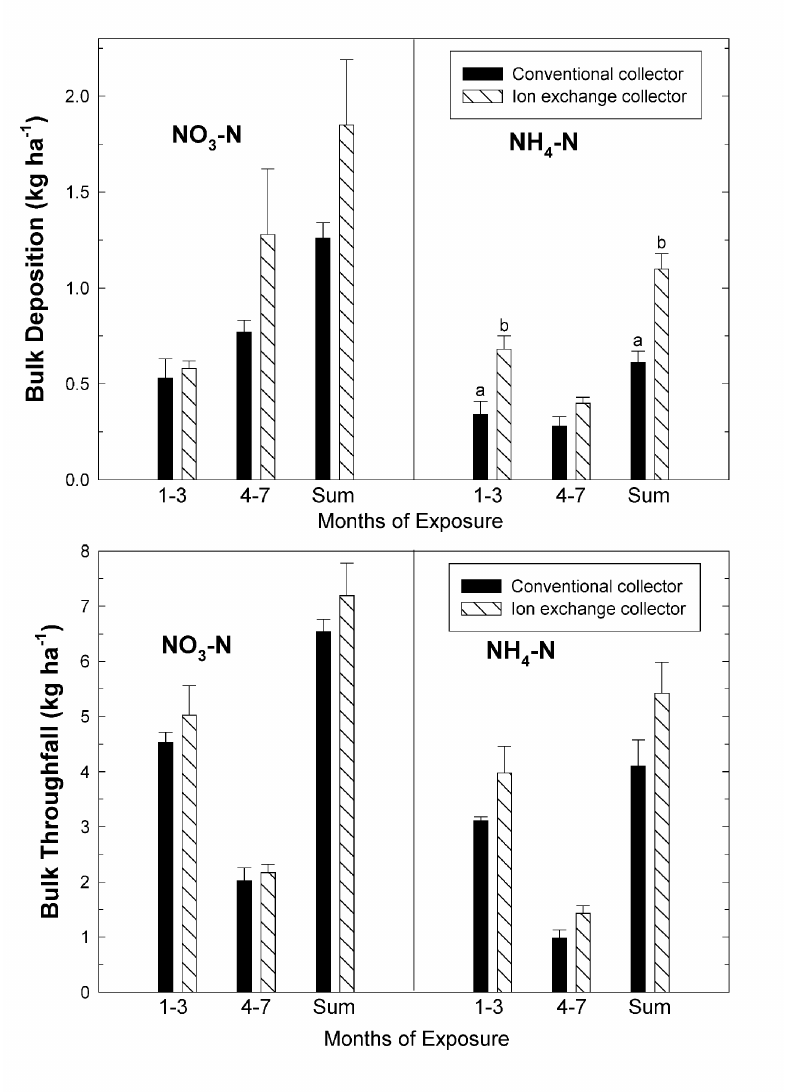
FIGURE 4 . Comparison of deposition of NO 3 -N and NH 4 -N to conventional throughfall solution collectors and ion exchange resin collectors under pine trees and in open areas (bulk deposition) at Barton Flats, a low deposition site in the San Bernardino Mountains. The first set of collectors was exposed for 3 months, followed by another set exposed for 4 months. Sum refers to total deposition during the two exposure periods combined. Letters above the error bars indicate significant differences ( p < 0.05) in deposition between the collector types for that exposure period (n = 20 for throughfall collectors and n = 4 for bulk deposition collectors in open